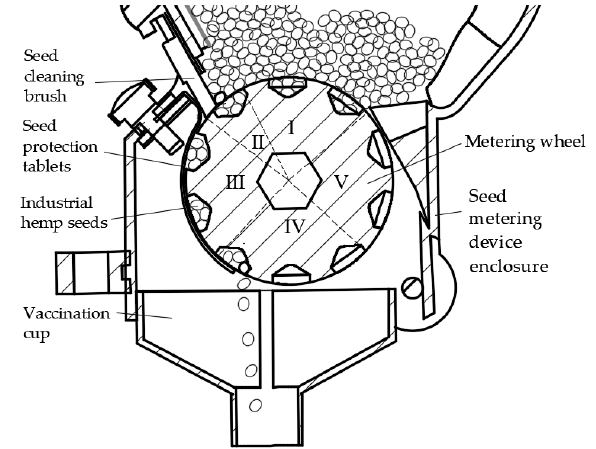
Figure 3. Operation process of seed metering device.